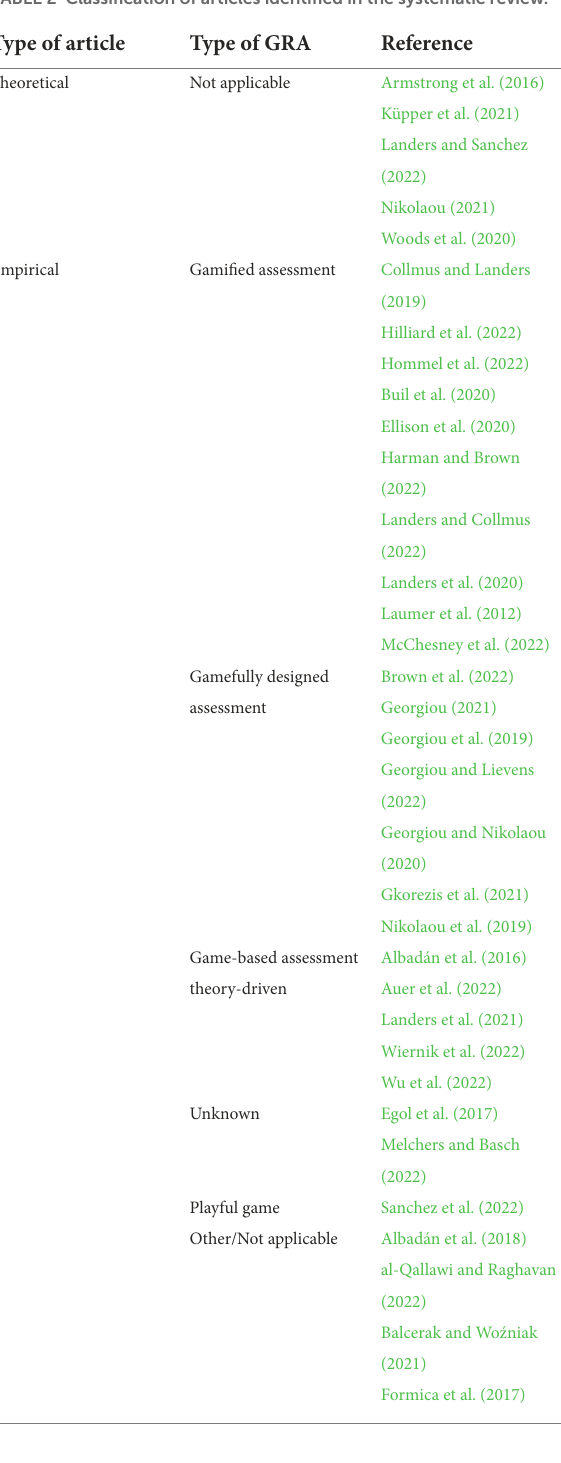
TABLE 2 Classification of articles identified in the systematic